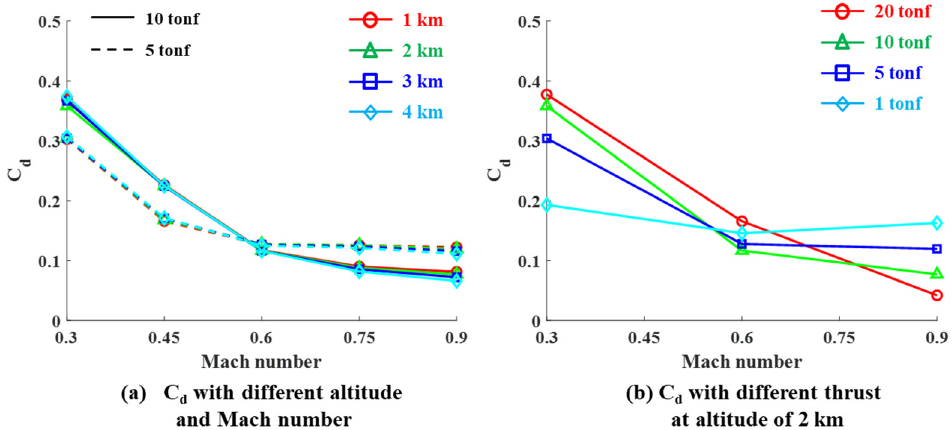
Figure 10. Drag coefficient in the landing-burn phase. ( a ) C d with different altitude and Mach number; ( b ) C d with different thrust at altitude of 2 km.